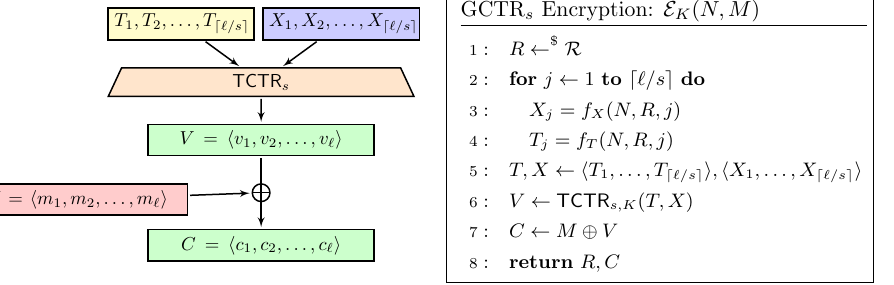
defining the security s , s-build